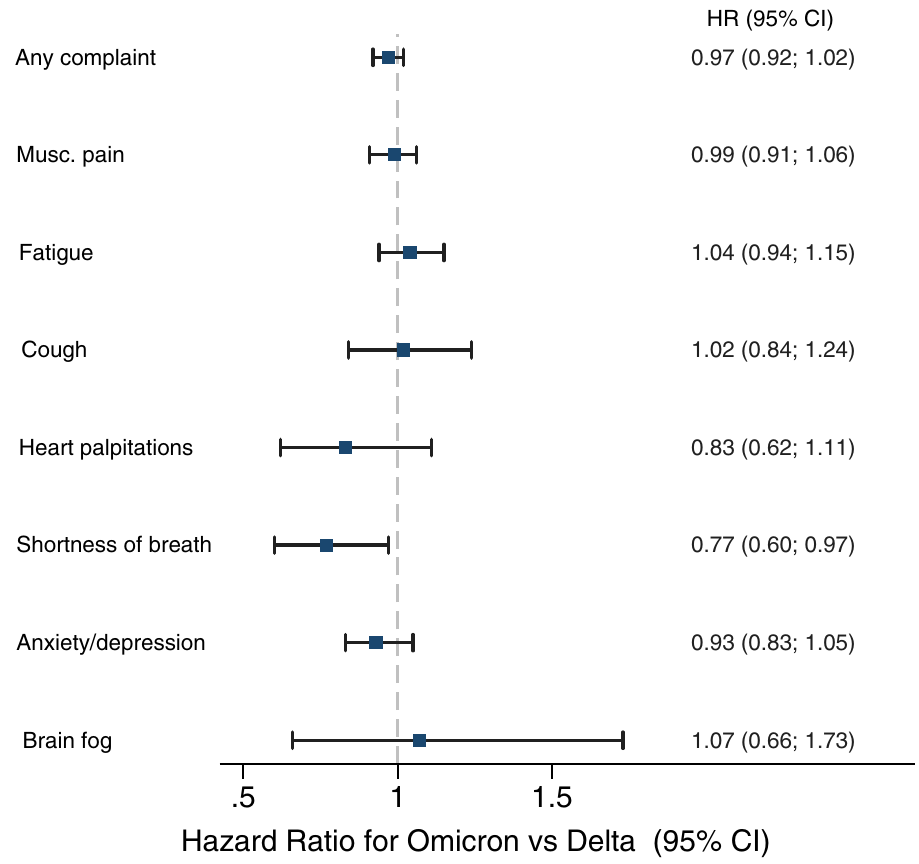
as Hazard Ratios (HR) with 95% con fi dence interval (CI) and examined over 8 independent experiments, one for each post-covid outcomes. Blue squares represent the estimates for the Omicron variant compared to the Delta variant. Musc. pain=musculoskeletal pain. Source data are provided as a Source Data fi